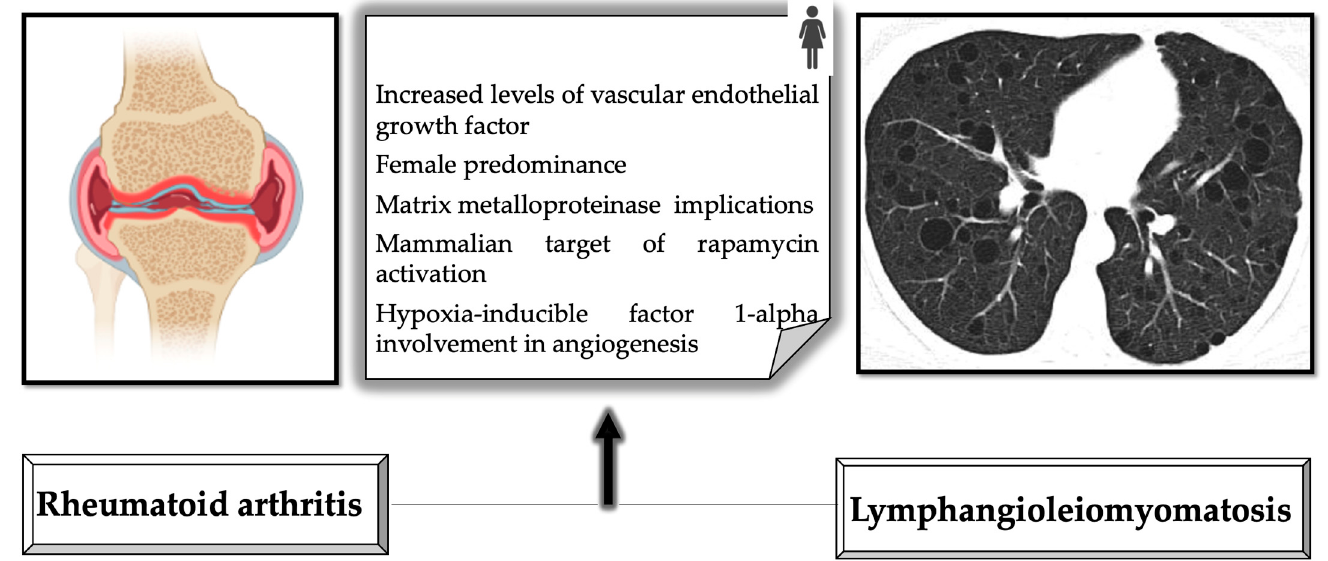
Figure 7. Description of shared processes in RA and LAM. There is increasing evidence of similarities between the molecules implicated in the pathophysiology of RA and LAM, suggesting a potential association between both disorders that requires further